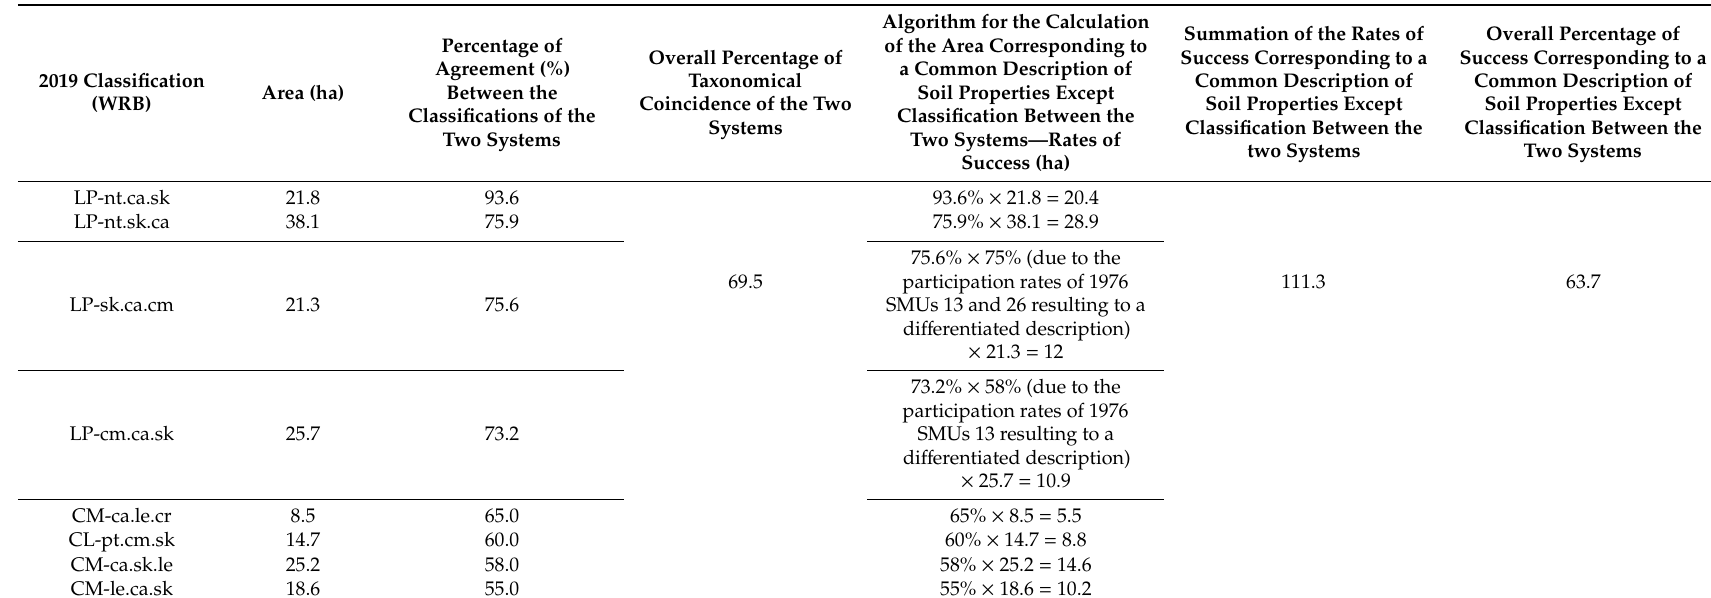
Table A12. Explanatory table of the methodology for comparison the results of the two